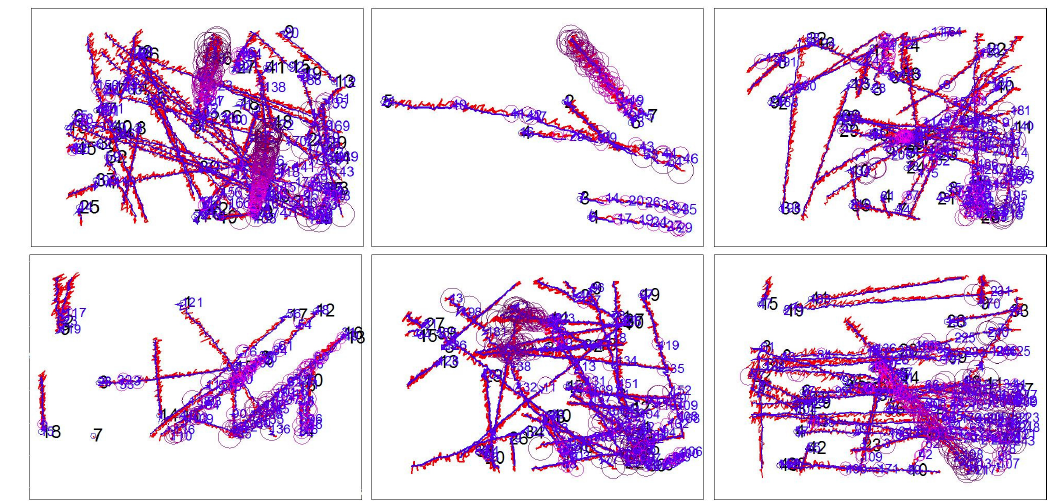
Figure 5. Example scenarios in the “final” sampling dataset (with noise): the red lines denote the true trajectories of ships with added noise, the blue lines denote the output tracks of the HFSWR ship-tracking algorithm, and the circles mark the fragmentation points of the tracks, with the bigger size and darker colour denoting later sampling